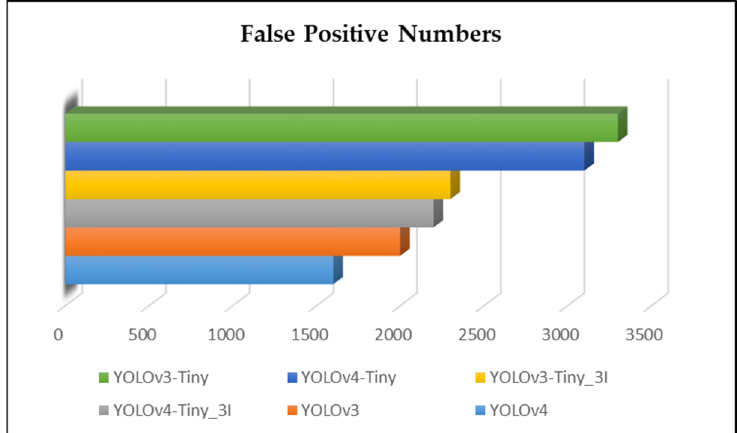
Figure 4. False-positive results in the weight files of the first